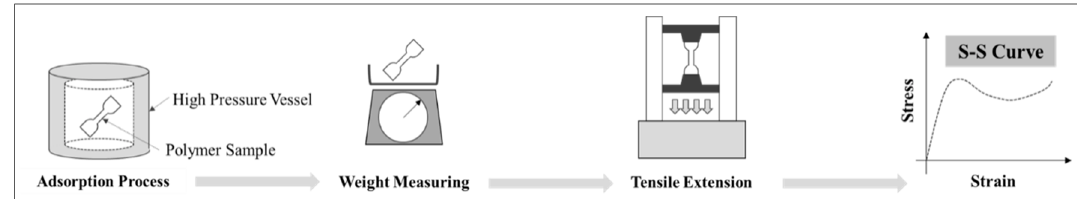
Figure 5. Experimental process for studying changes in the tensile strength through CO 2 adsorption.